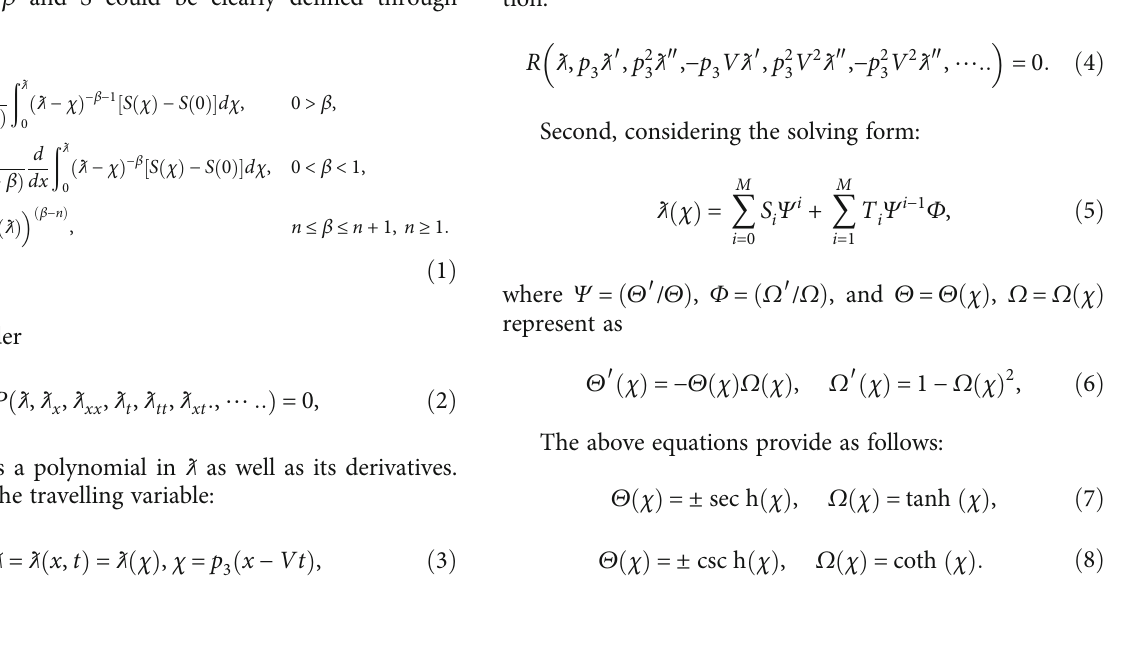
Figure 2: The graphical representation of the solution ƛ real contour plot, and (d) imaginary contour